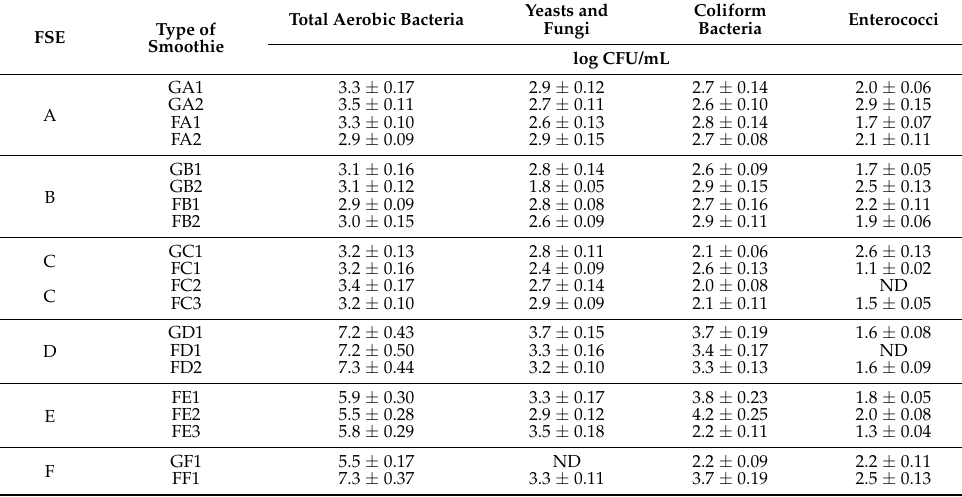
Table 3. Number of total fungi and bacteria in the smoothie samples. Total Aerobic Bacteria Yeasts and Fungi Coliform Bacteria FSE Type of Smoothie